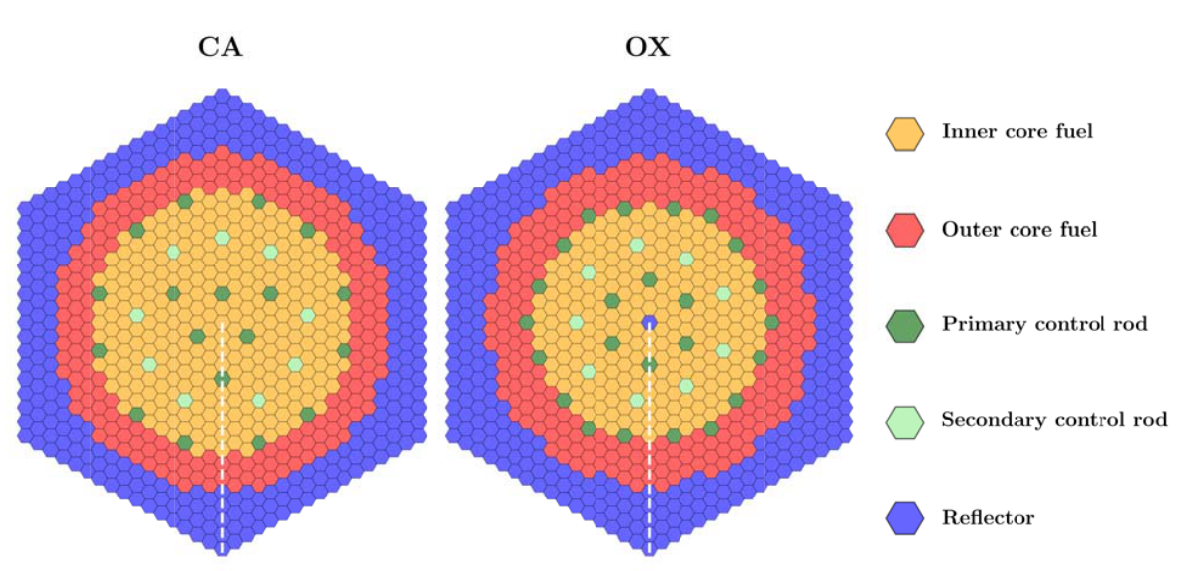
Figure 1: SFR Core